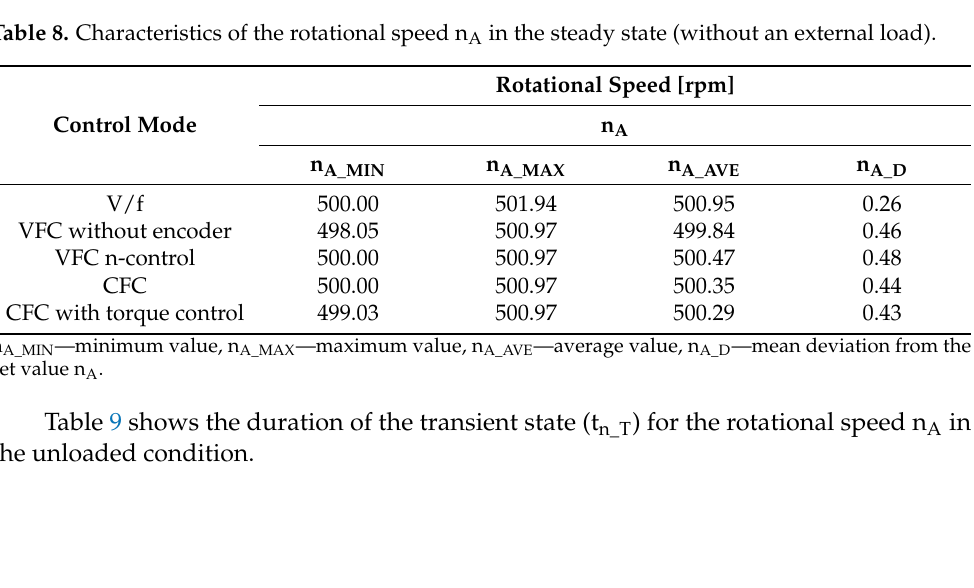
Table 8. Characteristics of the rotational speed n A in the steady state (without an external load).